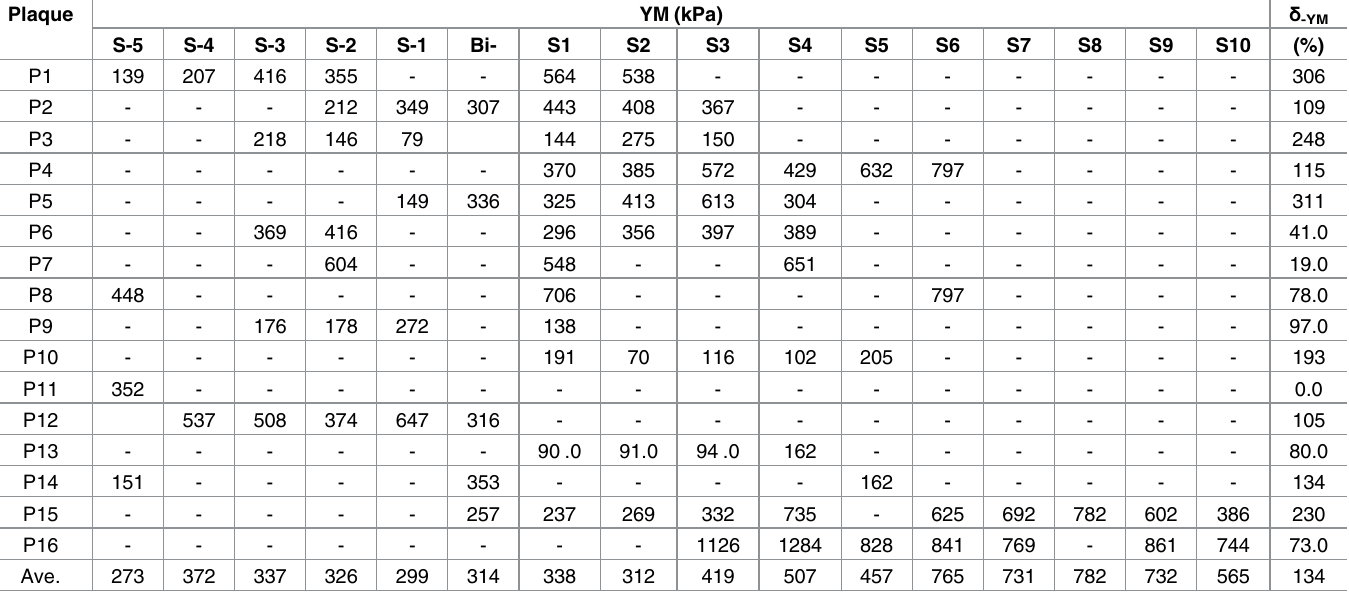
Table 4. The YM values for all slices from 16 plaque samples based on Cine MRI data. Plaque YM (kPa) δ